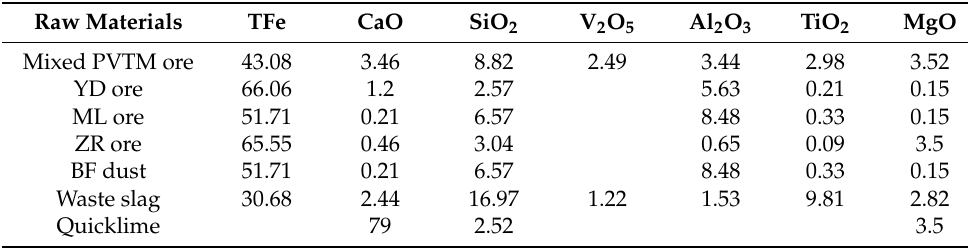
Table 1. Chemical composition of raw materials (mass fraction, %).